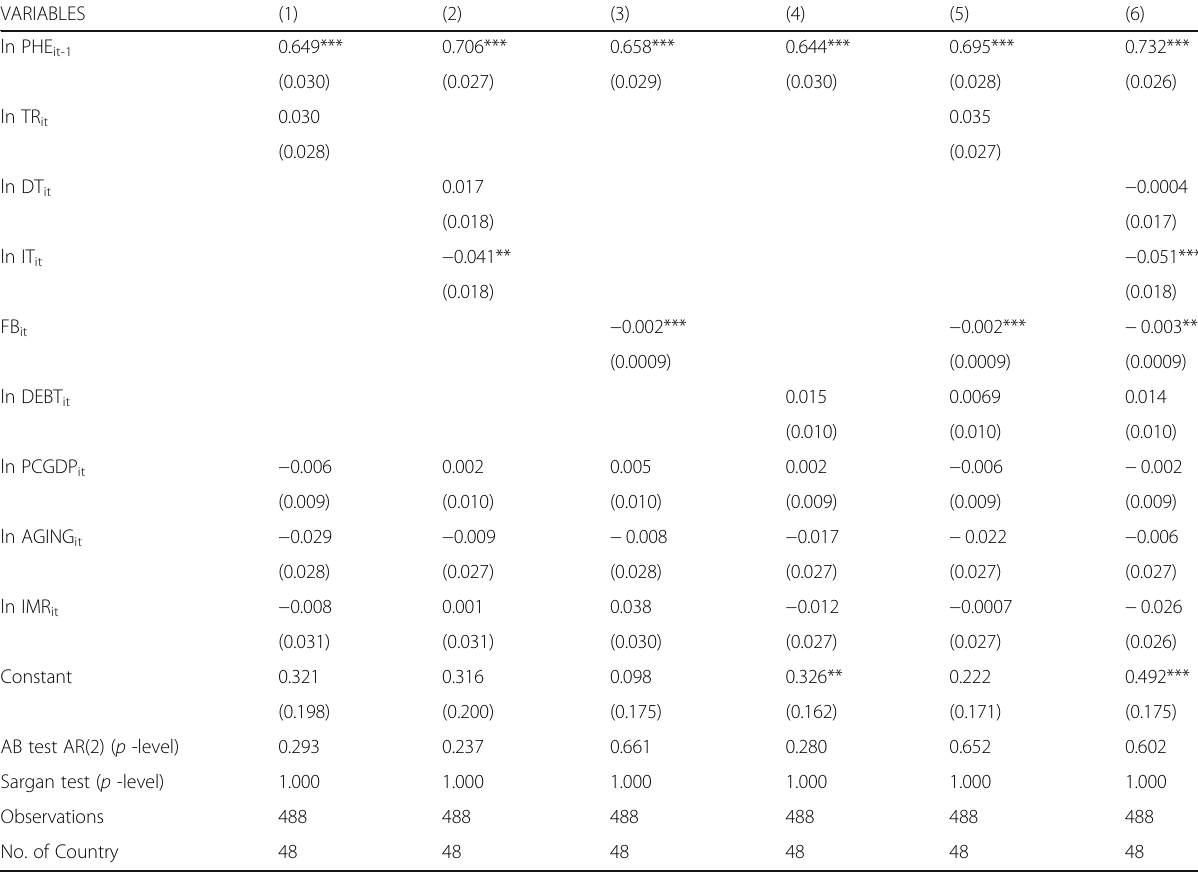
Table 4 Dynamic System GMM Regression Model (Low-Income countries)